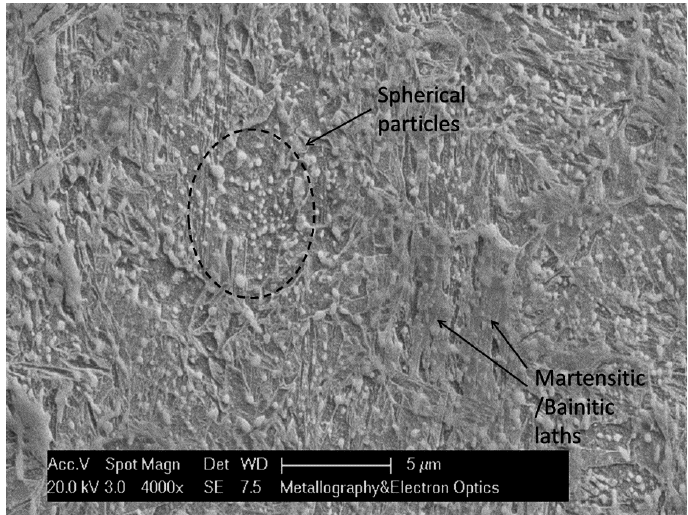
Figure 5. SEM image of the microstructure gained after UFHT. Martensitic/bainitic laths are descernible as well as coarse spherical paricles.